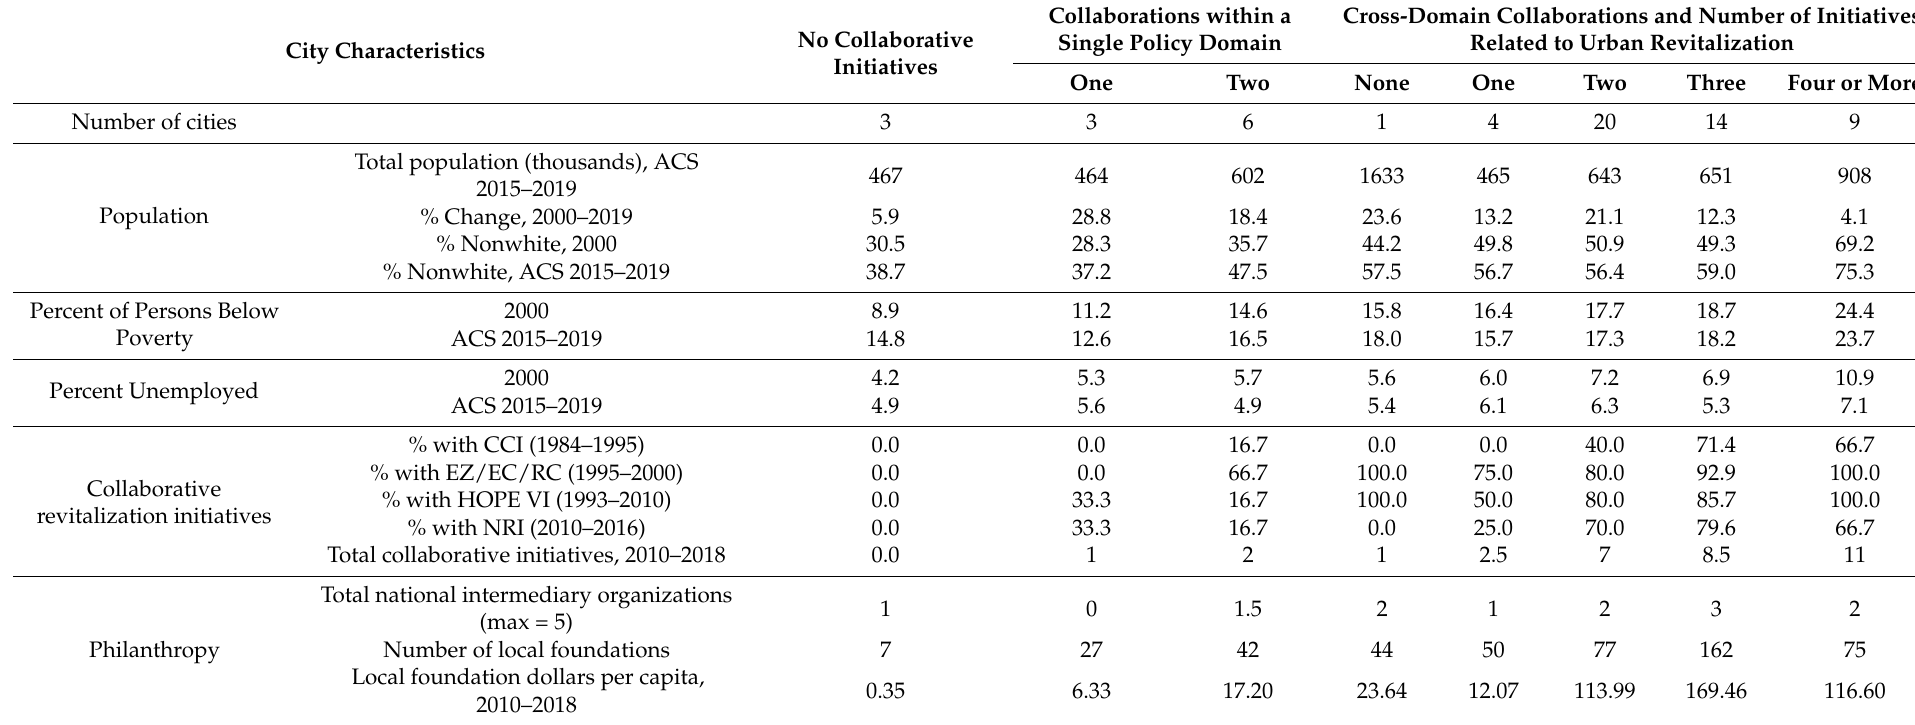
Table 1. City characteristics by experience with collaborative initiatives. Median values. Sources: U.S. Bureau of the Census, Decennial Census of Population (2000) and American Community Survey, ACS, (Five Year Estimates 2015–2019); authors’ inventory of community initiatives and tabulation of local philanthropic giving for poverty reduction and economic mobility initiatives in sample cities from search of the Foundation Directory. KEY: CCI Comprehensive community initiatives; EZ Empowerment Zones; EC Enterprise Communities; RC Renewal Communities; NRI Neighborhood Revitalization